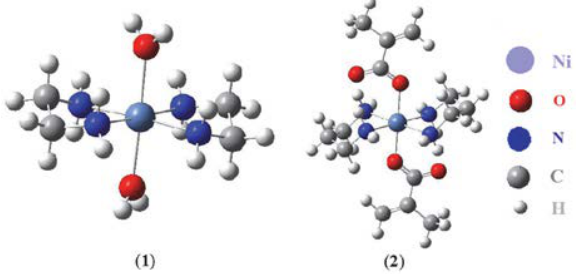
Fig. 4. The optimized structures of the complexes 1 and 2 .